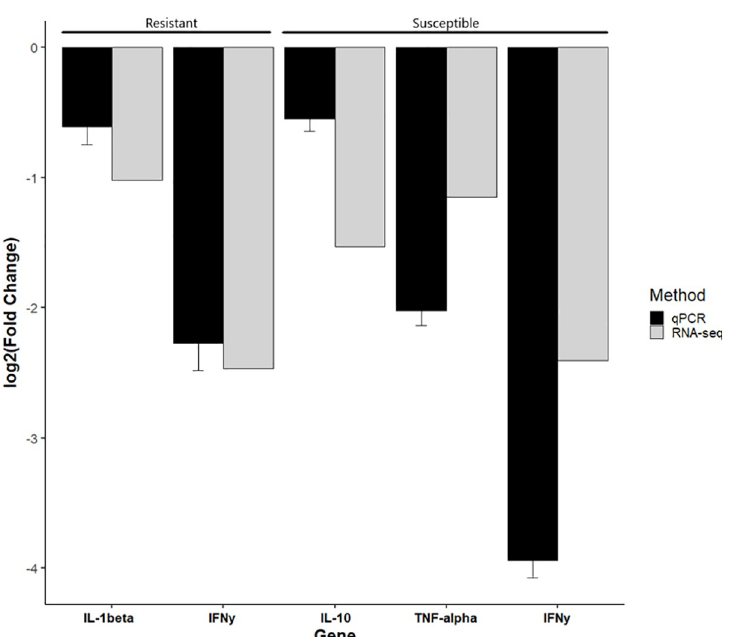
Fig 9. qPCR validation of RNA-seq results. Quantitative reverse transcription PCR (RT-qPCR) validation of four immune genes ( IFN- γ , TNF- α , IL-10 , IL-1 β ) found to be significantly differentially expression by RNA-seq at day 7 in the gills. The X-axis shows the gene and phenotype assayed and the Y-axis shows the relative log 2 (Fold Change) between fish exposed to Ceratonova shasta and their respective control. Error bars indicate the standard deviation of Cq values between biological